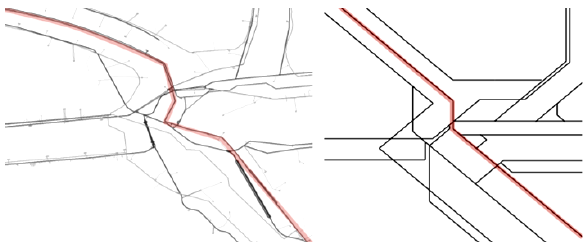
Figure 7. Comparison of network representations using original geodata (left) and schematic abstraction (right)